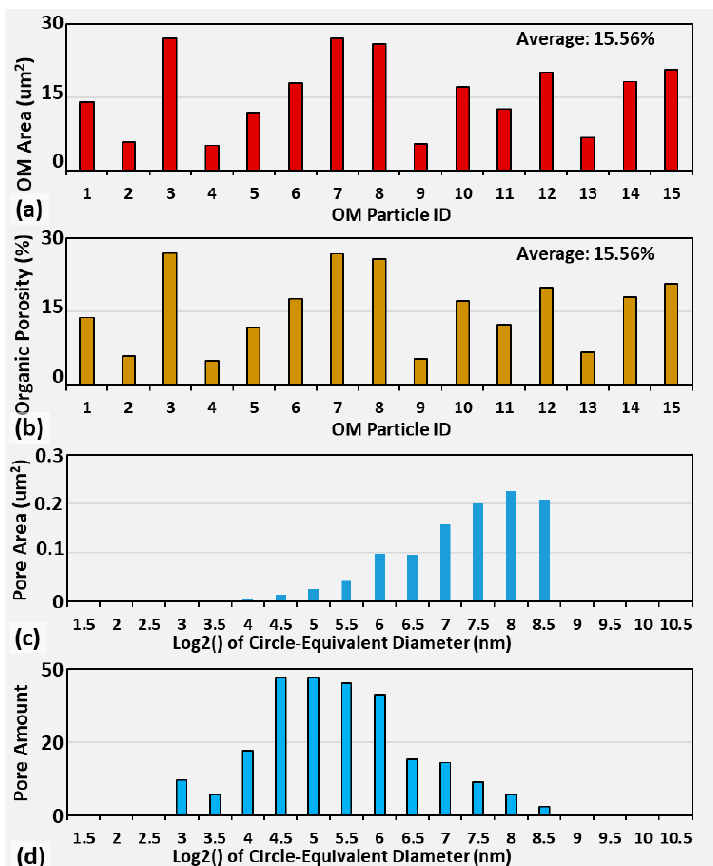
Figure 9. Statistical analysis of the 15 particles of OM III shown in Figure 8. ( a ) histogram of sectional area of the 15 particles of OM III; ( b ) histogram of organic porosity of the 15 particles of OM III; ( c ) pore size distribution determined by pore sectional area of all OM-hosted pores within the 15 OM III together; and ( d ) pore size distribution determined by pore amount of all OM-hosted pores within the 15 OM III together.